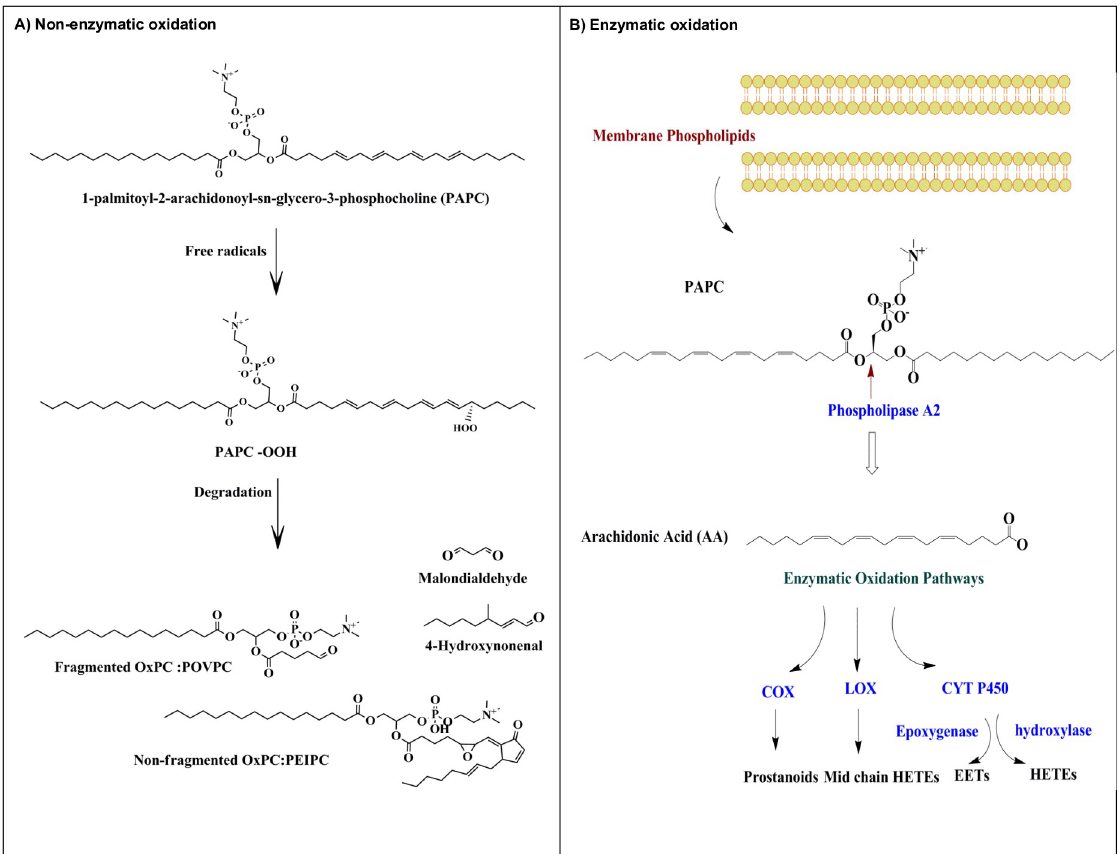
Fig 1. A] Non-enzymatic oxidation of membrane phospholipids. Free radicals may attack membrane phospholipids such as PAPC, leading to the production of bioactive lipid molecules. Abbreviations: PAPC-OOH, PAPC hydroproxide; OxPC, oxidized phosphatidylcholine; PEIPC, 1-palmitoyl-2-[5,6-epoxyisoprostane E2]-sn-glycero-3-phosphocoline. B] Enzymatic oxidation of membrane phospholipids. Fatty acids are released from the membrane phospholipid by the phospholipase A2 enzyme and may undergo oxidation through three oxidation pathways including COX, LOX, and CYT P450. Abbreviations: COX, cyclooxygenase; LOX, lipoxygenase; CTYP450, cytochrome P450; HETE; hydroxyeicosatetraenoic acids; EET, epoxyeicosatrienoic acids.